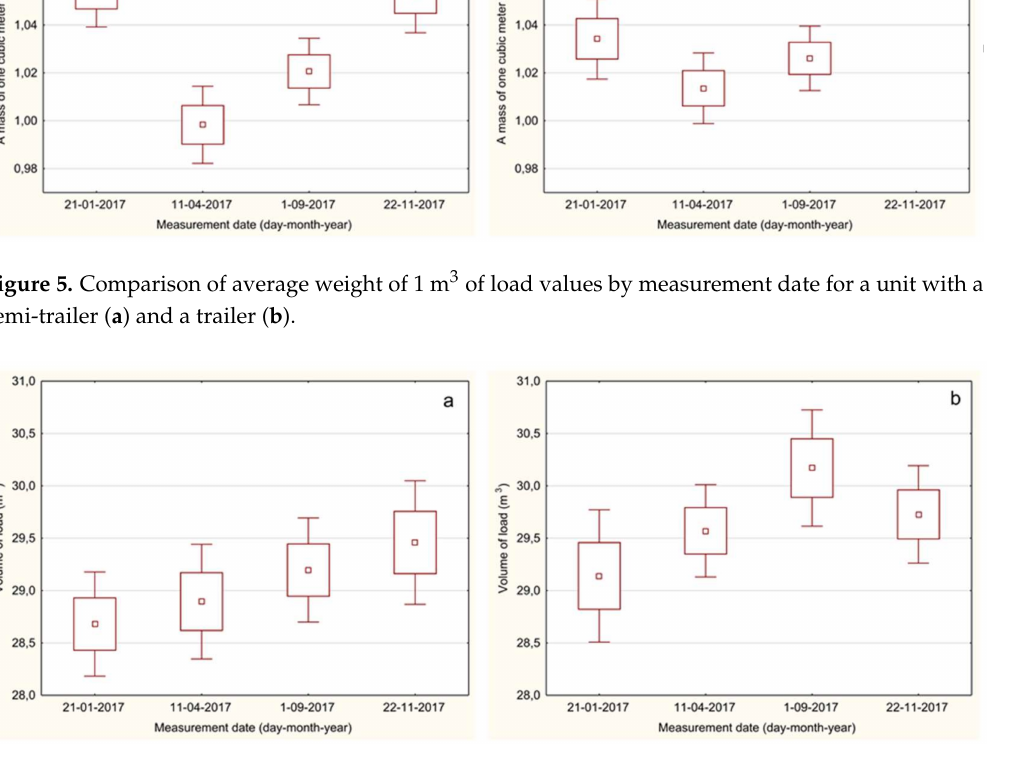
Figure 6. Comparison of average load volume values by measurement date for a unit with a semi-trailer ( a ) and a trailer ( b